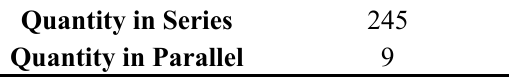
Table 4. The calculated results for the battery